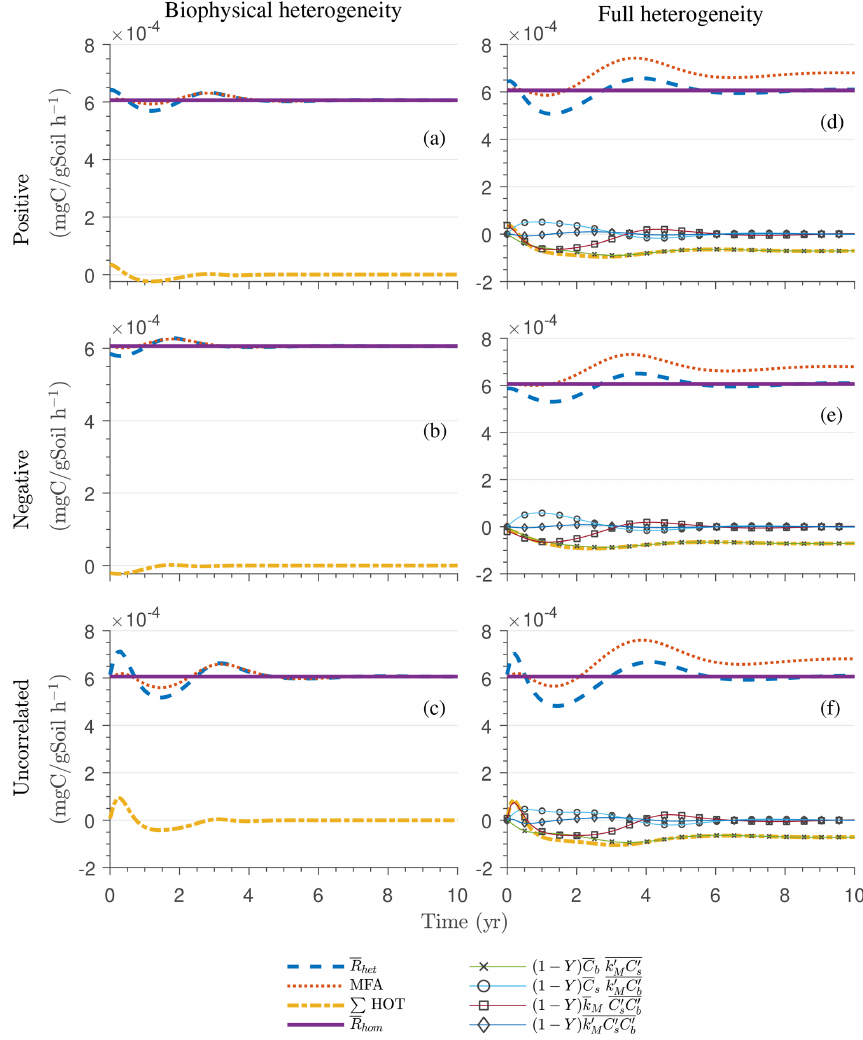
Figure A3. Scenario 1 (steady-state simulation): temporal evolution of mean respiration rate in the heterogeneous system ( R het , including the mean field approximation (MFA) and second-order terms) and the respiration rate in the homogeneous system ( R hom ) for multiplicative kinetics and for (a–c) the biophysical and (d–f) the fully heterogeneous system with (a–d) positively and (b–e) negatively correlated or (c–f) uncorrelated initial substrate and microbial